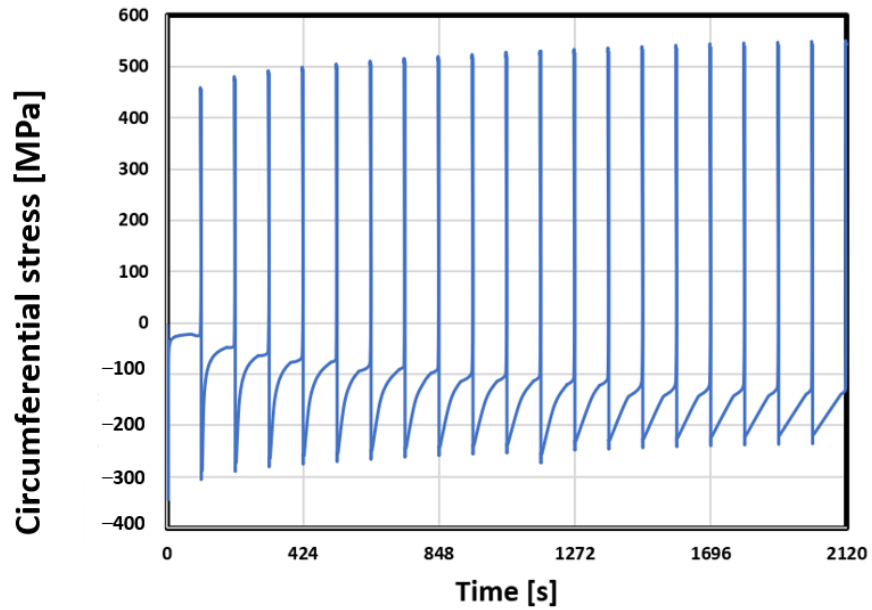
Figure 13 Figure 13. Circumferential stress vs.